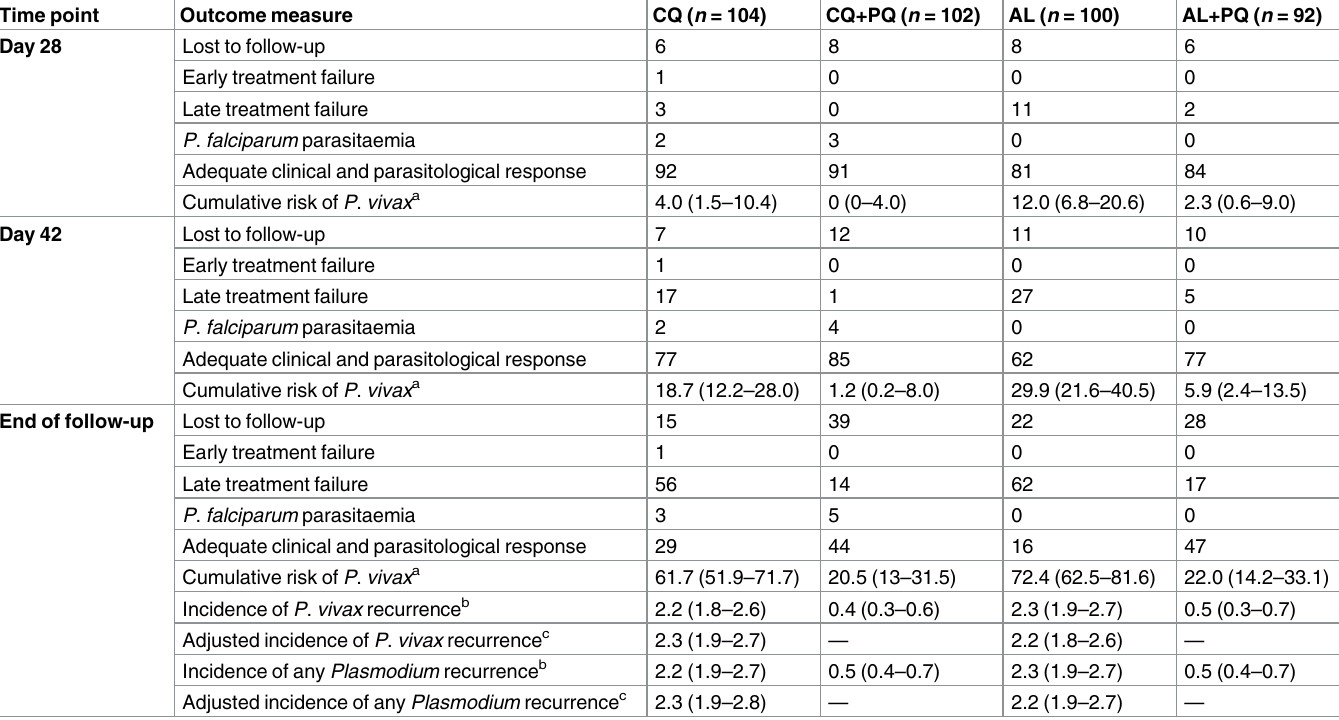
Table 2. Treatment failure and risk and incidence of recurrent